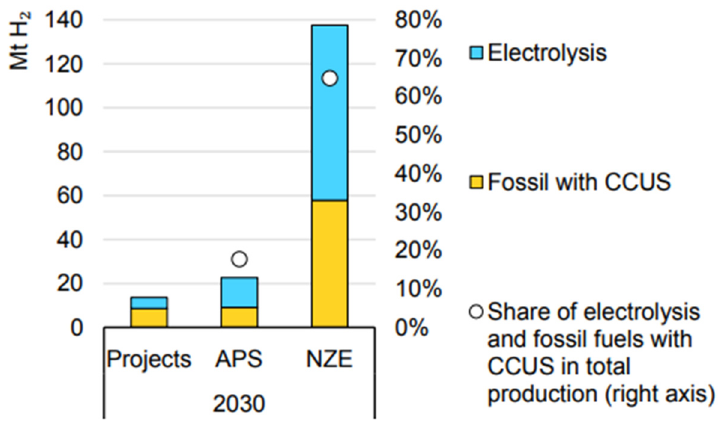
Figure 3. Green (electrolysis) and blue hydrogen production in different scenarios [2].